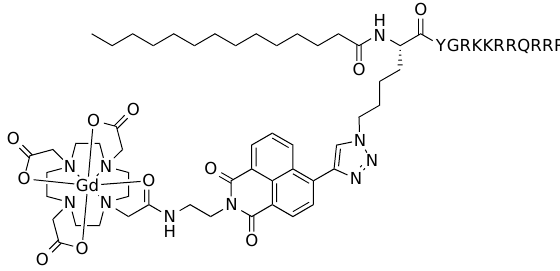
Figure 2. Structure of Gd-L-bearing myristylated Tat peptide conjugate.